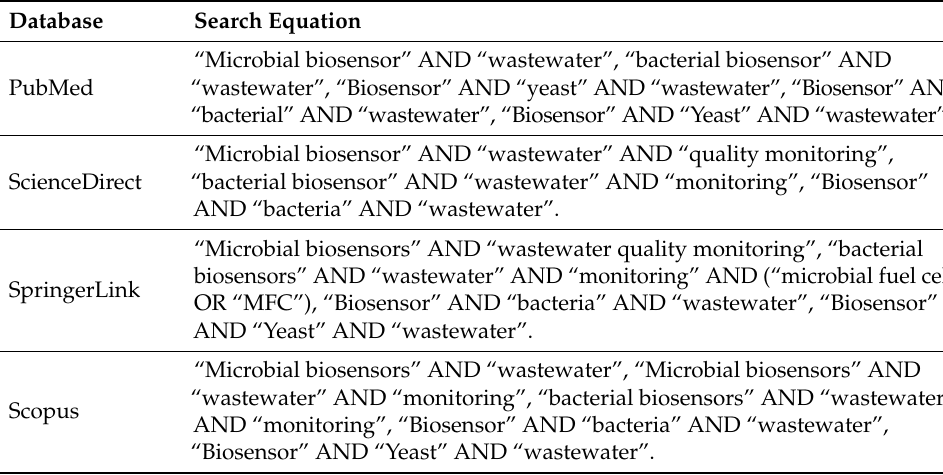
Table 1. Search equations used in the publication search.